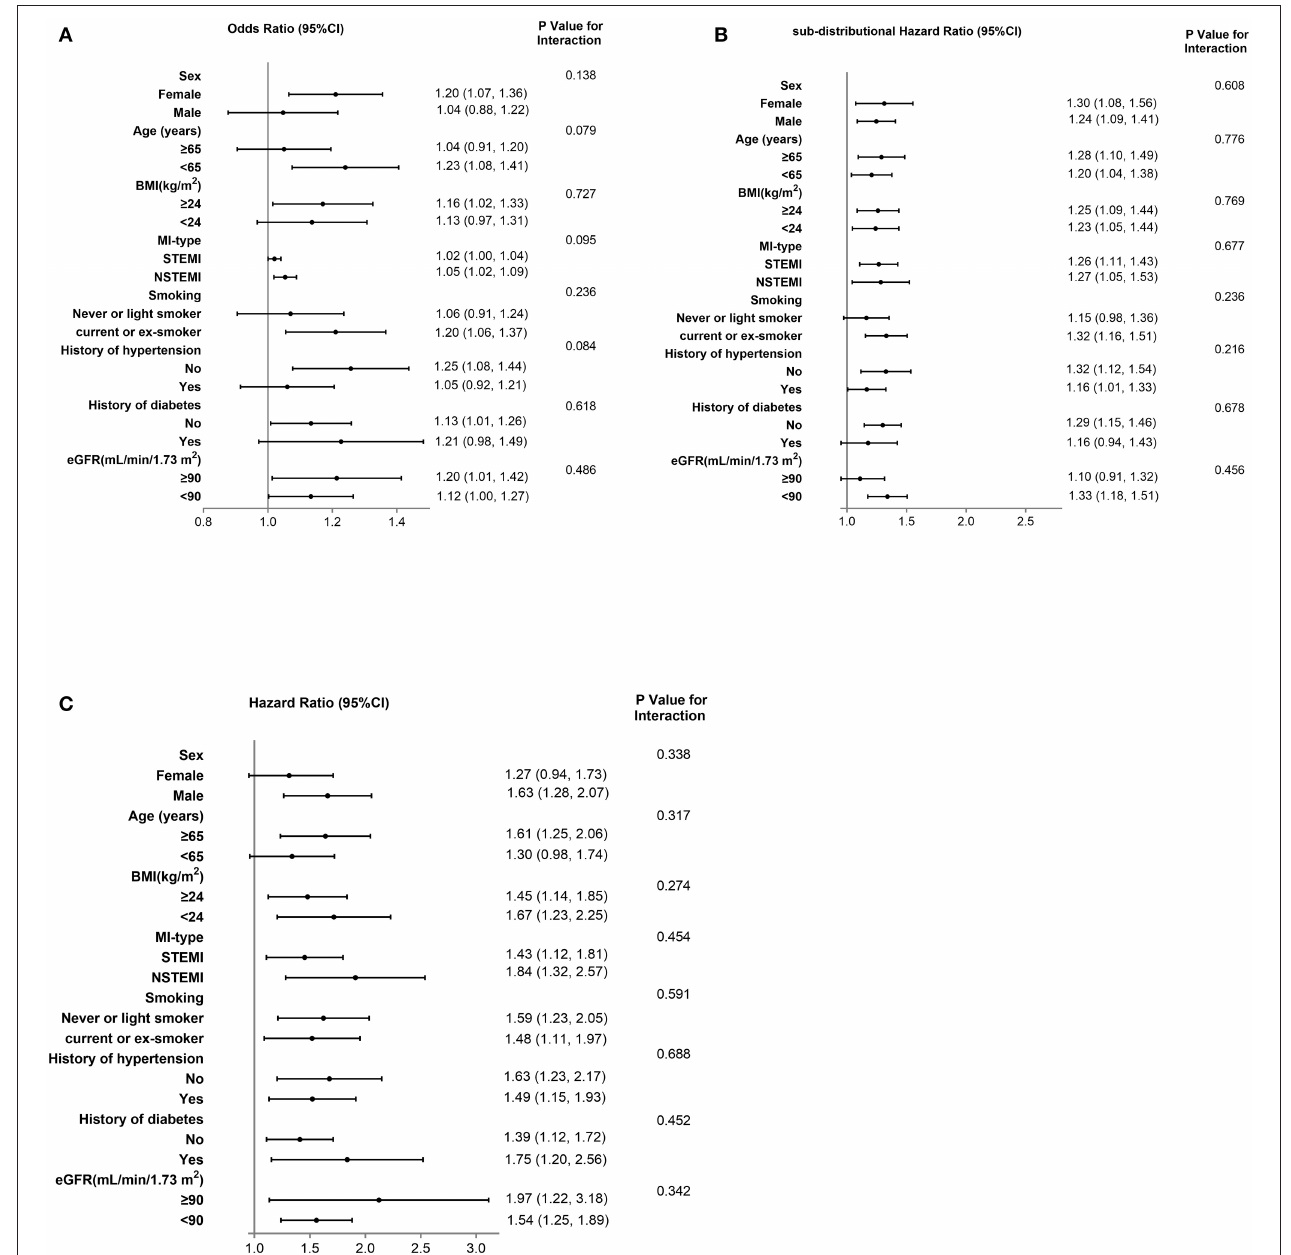
FIGURE 4 | Stratified analysis of in-hospital HF based on model II (A) , HF after hospitalization (B) and Death based on model V (C) . CI, confidence interval; STEMI, ST-segment elevation myocardial infarction; NSTEMI, non–ST-segment elevation myocardial infarction; BMI, Body mass index; eGFR, estimated glomerular filtration